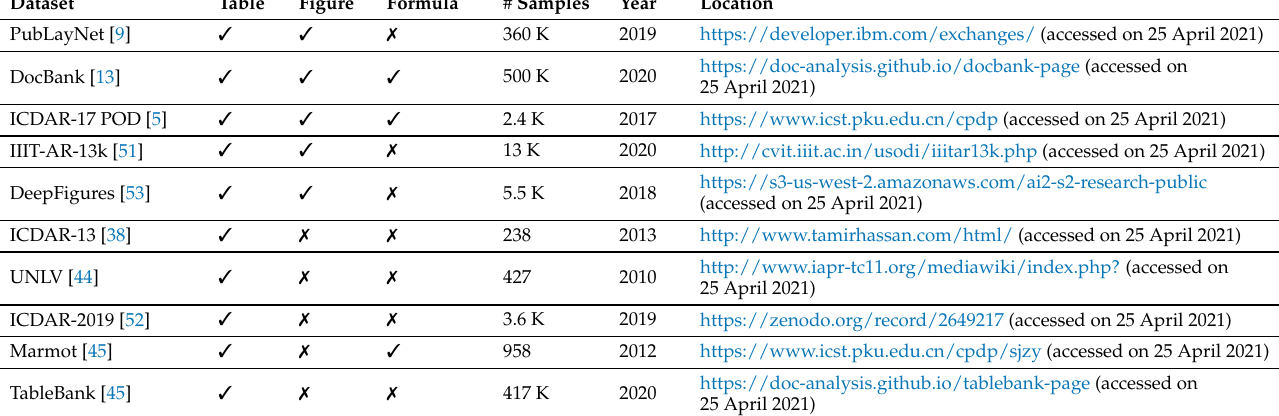
Table 2. Graphical page object datasets. It is important to mention that we have considered equation and formula as semantically equal in this table. Some of these datasets contain as many as 12 page objects [13]. For the sake of convenience, we have only included table, figure, and formula. Dataset Figure Formula # Samples Year